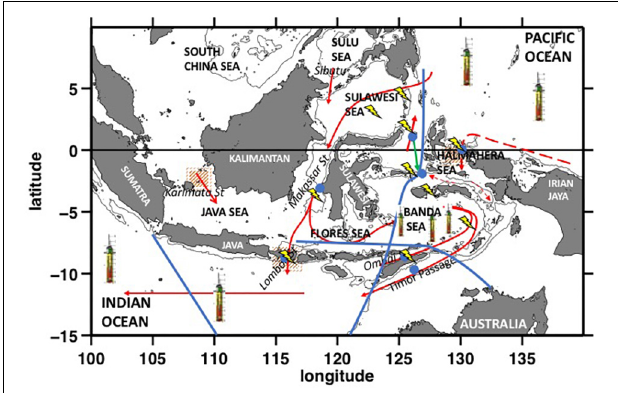
FIGURE 15 | Schematic of proposed intensive pilot study and enhanced mixing array for the Indonesian seas. The array includes (multiple) moorings in straits (blue dots); XBT transects (blue lines); acoustic tomography and/or high frequency radar (orange hatched); Argo/BGC/EM-APEX floats (float icon) and microstructure measurements (yellow lightening). Upper ocean current pathway is in red, lower pathway in green. Dashed lines indicate uncertain